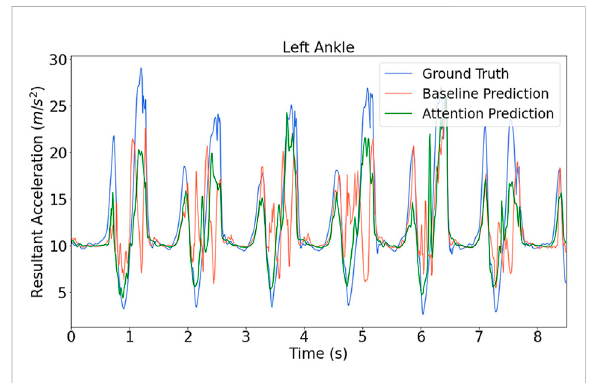
FIGURE 7 Model prediction for the ankle acceleration on the testing data from